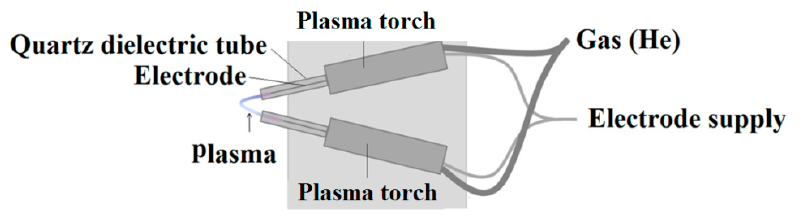
Figure 2. Scheme of V-FAPA (flowing atmospheric-pressure afterglow) ambient plasma source.